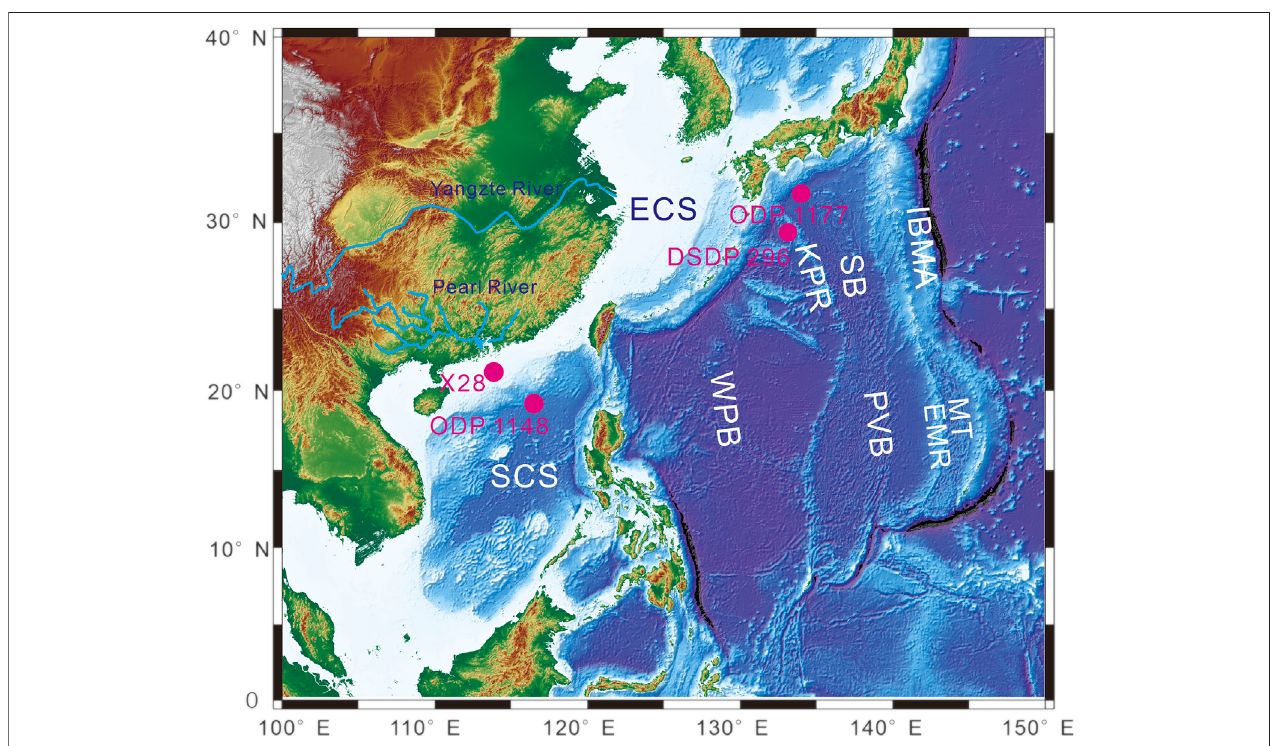
FIGURE 1 | Schematic map showing the studying area. Sites mentioned in this study are indicated by the purple circles. SCS = South China Sea, WPB = West Philippine Basin, KPR = Kyushu-Palau Ridge, SB = Shikoku Basin, PVB = Parece Vela Basin, EMR = East Mariana Ridge, MT = Mariana Trough, IBMA = Izu-Bonin- Mariana Arc, ECS = East China